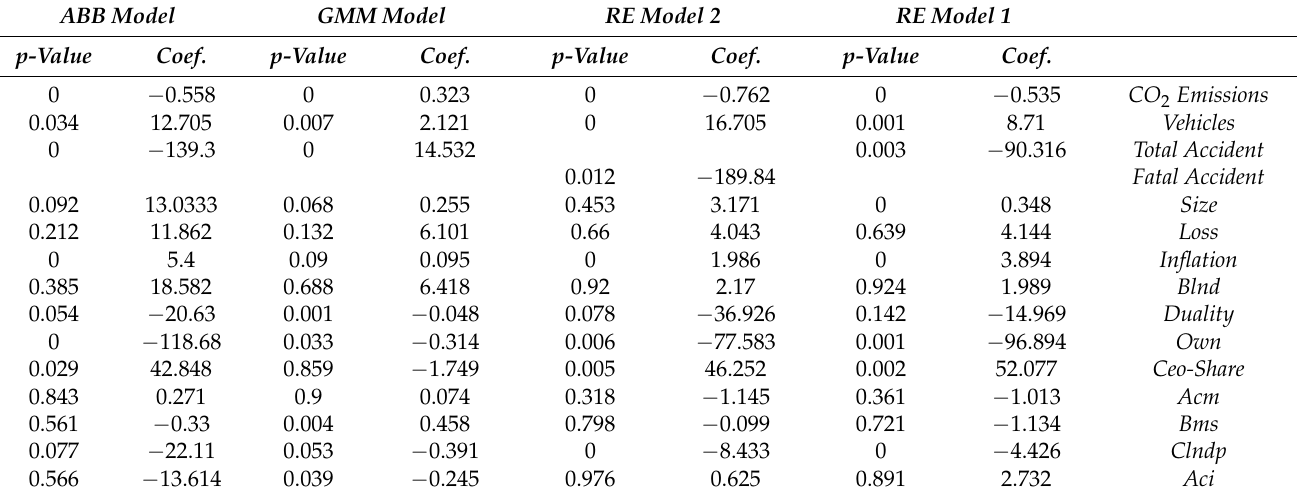
Table 5. The results of the effect of CO 2 emissions on stock prices of automotive